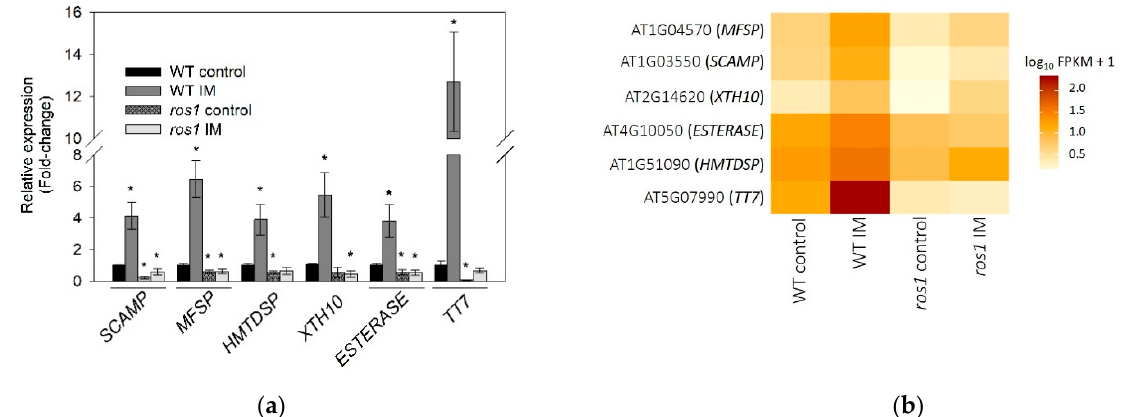
Figure 7. Transcriptionally regulated genes in response to herbicide application in wild type (WT) A. thaliana are not upregulated in the ros1 mutant. ( a ) Quantitative PCR validation (fold-change) of genes from the differentially expressed genes (DEGs) profiling. Error bars indicate the standard deviation of three biological replicates and asterisks indicate significant differences between the treatments and A. thaliana wild type (WT) control according to t -test ( p < 0.05); * compared to WT control. ( b ) Differentially expressed genes (DEGs) were performed by using CummeRbund, comparing genes in response to imazethapyr (IM) in A. thaliana wild type (WT) and ros1 , the gene-normalized signal intensities are shown in the heat map.